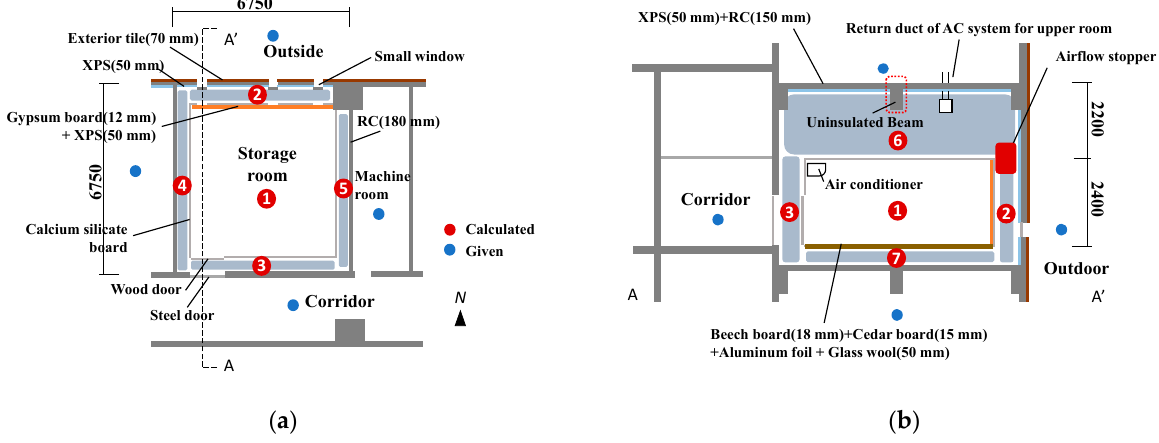
Figure 4. Outline of the storage room: ( a ) floor plan; ( b ) cross-sectional view A–A’. Normally, no mechanical ventilation system was used in the room, and the three windows on the northern outer wall were usually closed. However, airflow through the gaps in the closed doors and windows could occur. Although an air conditioner was installed in the room, it was not normally used.